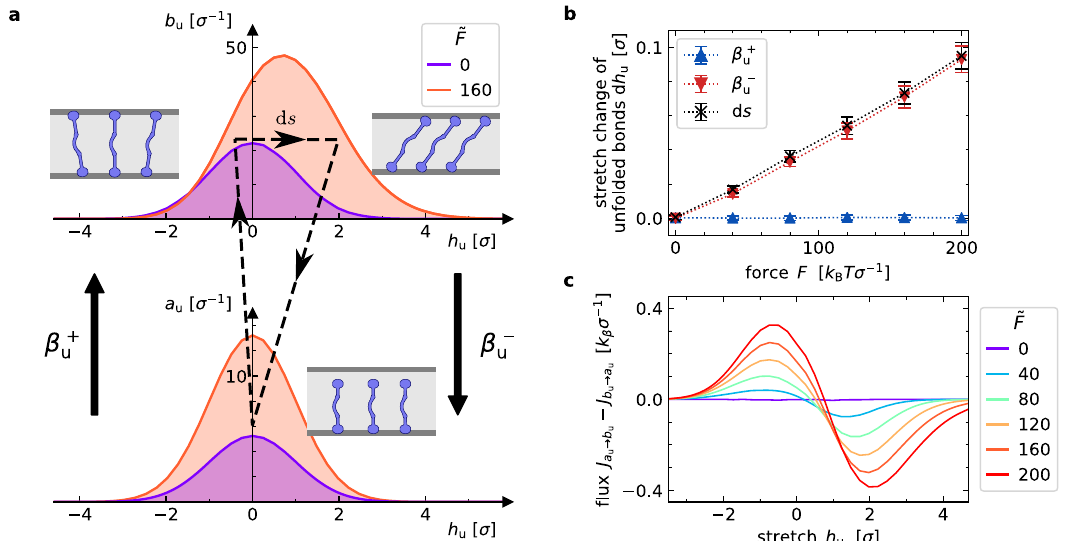
Fig. 3 Constant mechanical load maintains a non-equilibrium steady state. a Stretch distributions for unfolded-molecule states b u ( h u ) and a u ( h u ). Binding occurs symmetrically around h u = 0. Bonds exhibit a positively skewed stretch distribution under non-zero force. Cyclic stretch changes occur through binding, loading, and rupture (dashed line). b Average stretch changes during binding ( β þ ), rupture ( β (cid:2) ), and the average acquired stretch in the bound u u state d s for unfolded molecules. Error bars indicate sample standard deviation. c) Stretch-dependent fl ux-balance distributions for binding and unbinding of unfolded molecules. At vanishing forces, fl uxes are balanced for all h u . For F > 0, a net probability fl ux into state b u at negative stretches and a net fl ux out of state b u at positive stretches is found. Fluxes are obtained by binning the transition rates that are chosen in steady state simulation trajectories with a bin width 0.25 σ . Parameter values are given in Supplementary Notes